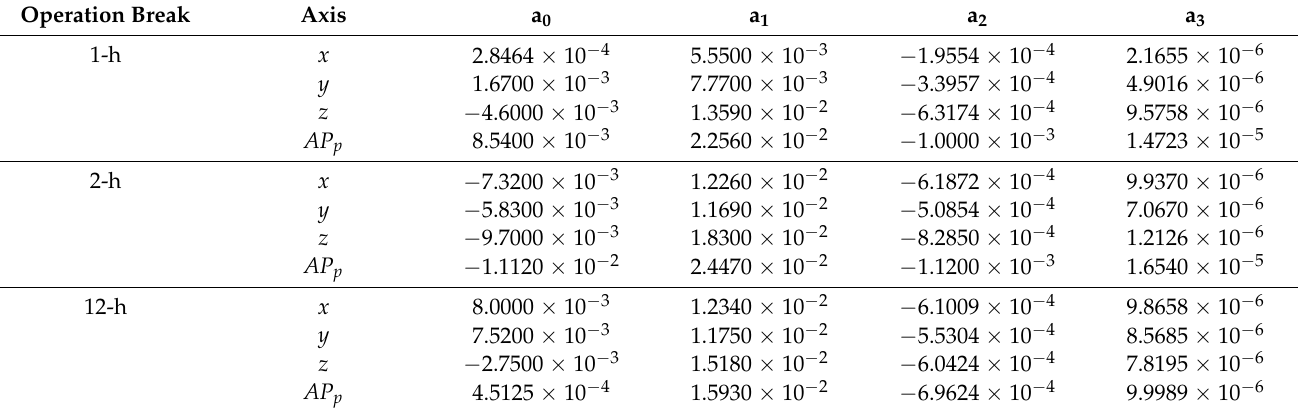
Figure 8. Positioning error dependency on time after: ( a ) 12 h operation break; ( b ) 1-h operation break; ( c ) 2-h operation break; ( d ) general positioning errors APp , calculated by Equation (4) after 1, 2, and 12 h breaks. Trend lines—regression approximation. Table 3. Coefficients for the regression estimated robot positioning error.